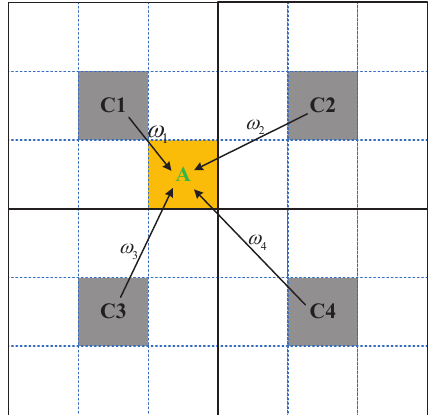
Figure 2. Illustration of the image reconstruction. A represents the current pixel to be reconstructed and C1, C2, C3, and C4 represent the four superpixel centers in a 3 × 3 squared grid around